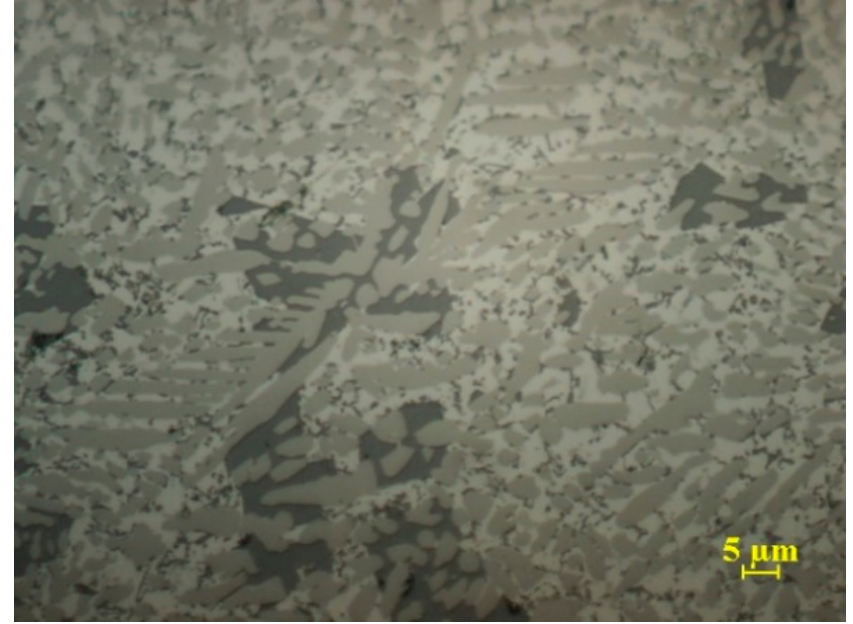
Figure 2. Metallographic structure of a powder particle obtained by atomization in argon, from the Al 79 Si 11 Ni 10 alloy.